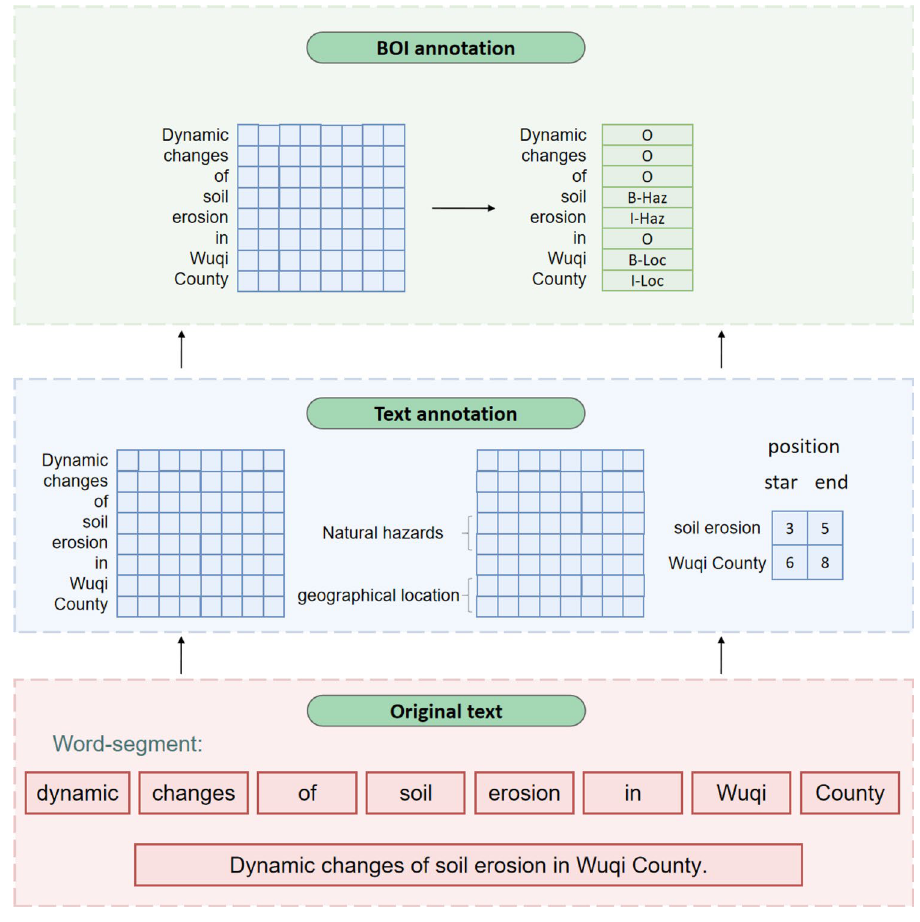
Figure 4. Labeling